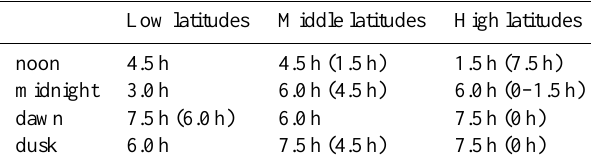
Table 3. The MLDT of the storm-time density changes with B at different local time sectors for high, middle and low